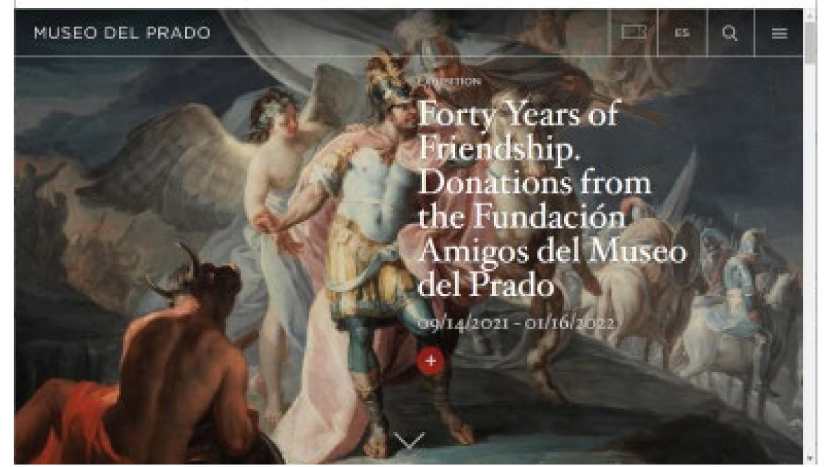
Figure 6. The website of the Prado museum